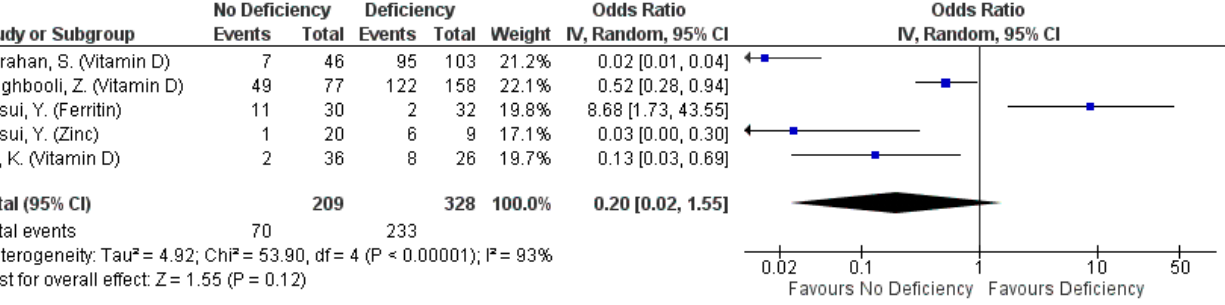
Figure 6. Pooled odds ratio on clinical severity of COVID-19 patients (defined by clinical condition, or need for breathing support) hospitalized subjects are not deficient, compared to those deficient in any micronutrient singly.